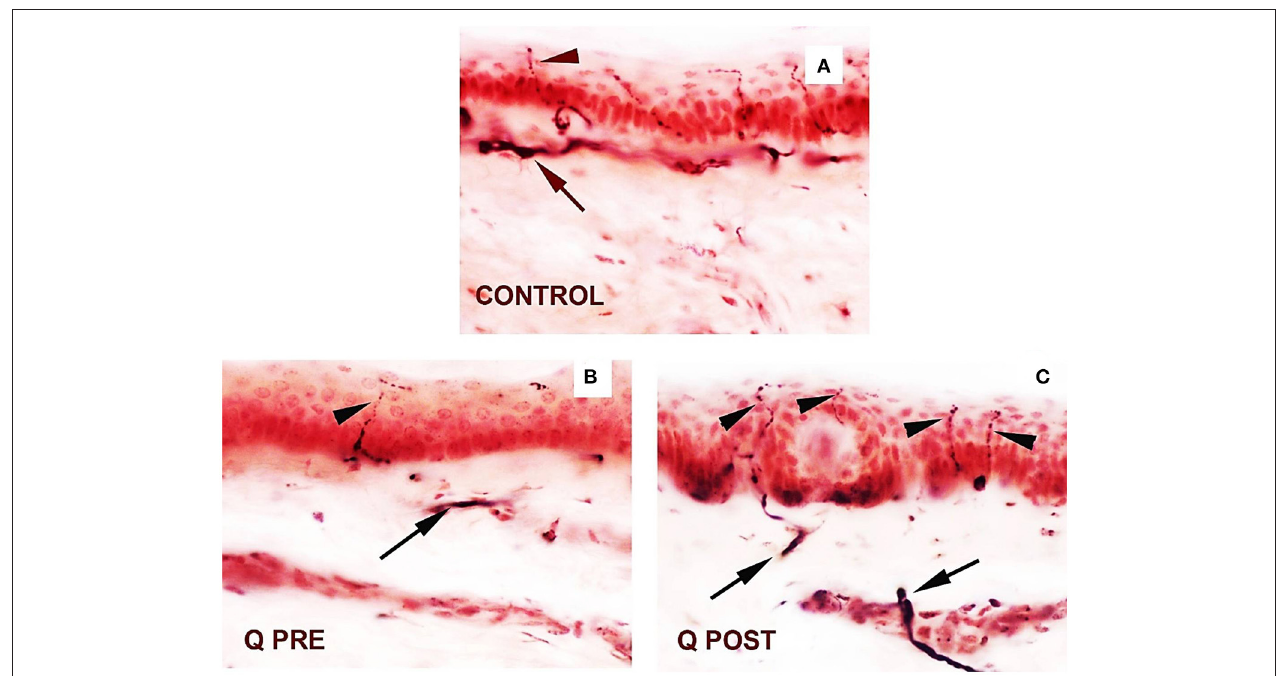
FIGURE 3 | Skin sections staining for PGP9.5 before and after application of Capsaicin 8% patch. (A) Control skin biopsy section, from a healthy human volunteer (intra-epidermal nerve fibre marked with arrowhead, and sub-epidermal nerve fibre with arrow). (B) Skin biopsy section from a participant with NFCI, pre-treatment (Q PRE); few intra-epidermal nerve fibres and sub-epidermal nerve fibres were observed before Capsaicin 8% patch Qutenza (Q) application. (C) Skin biopsy section from same participant as above with NFCI, post-treatment (Q POST); 3 months after Capsaicin 8% patch application, the abundance of both the IENFs and SENFs appeared restored. Magnification ×